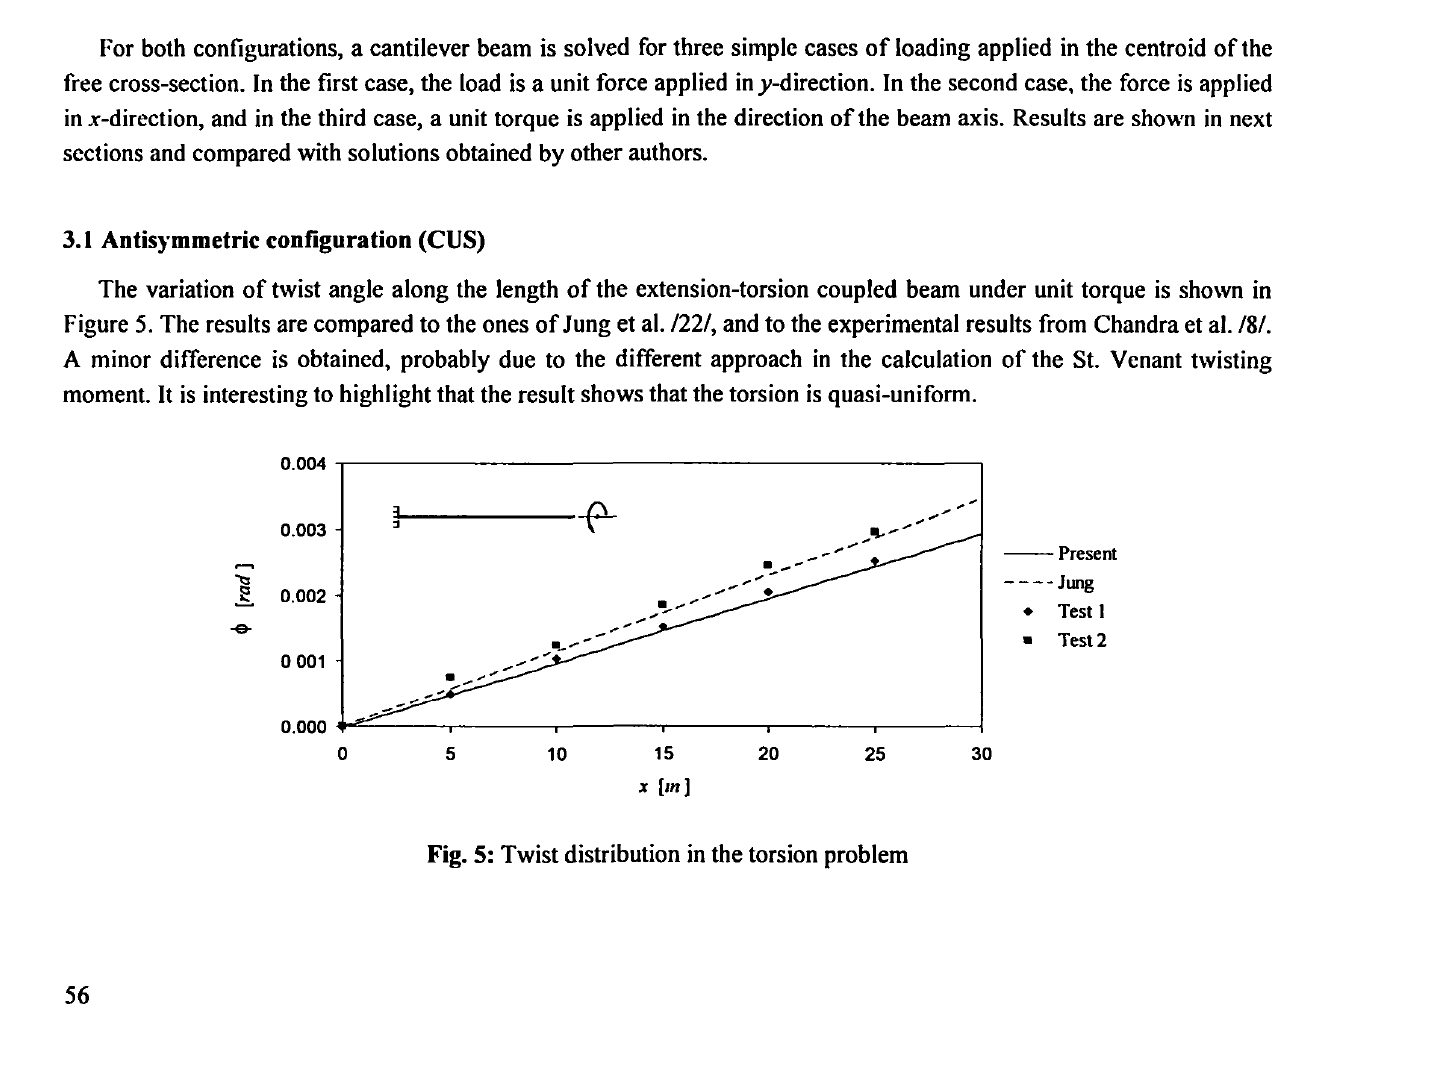
Fig. 5: Twist distribution in the torsion